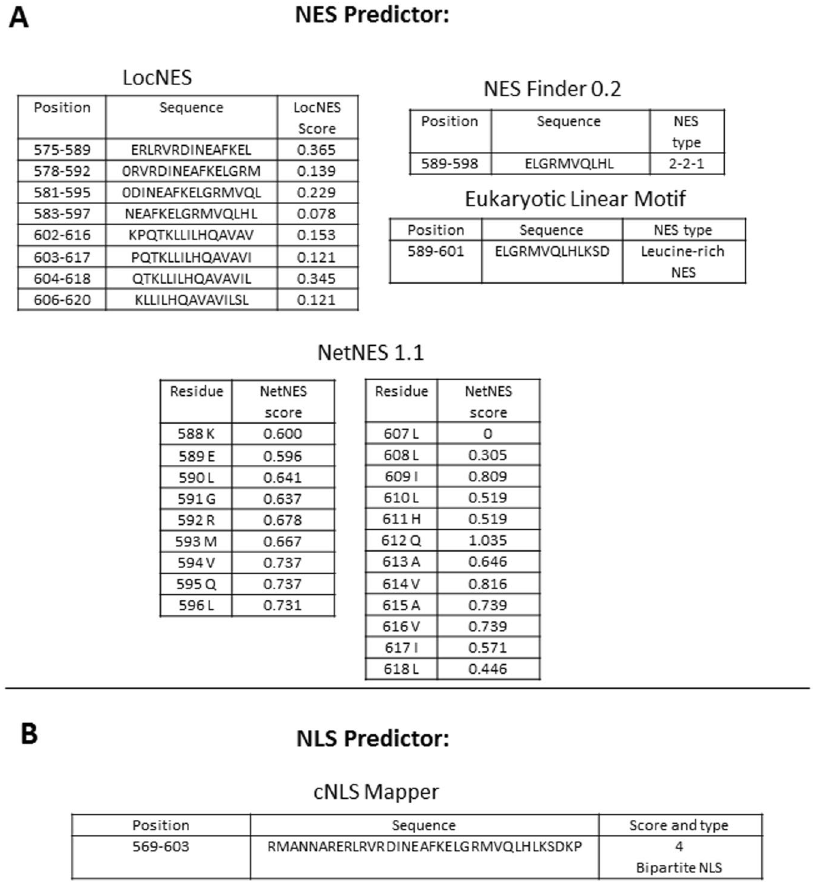
Figure 5. NES and NLS prediction in the bHLH domain of TCF4. ( A ) Results of NES prediction using LocNES, NES Finder 0,2, NetNES1.1. and ELM servers. ( B ) Results of NLS prediction using the cNLSMappes